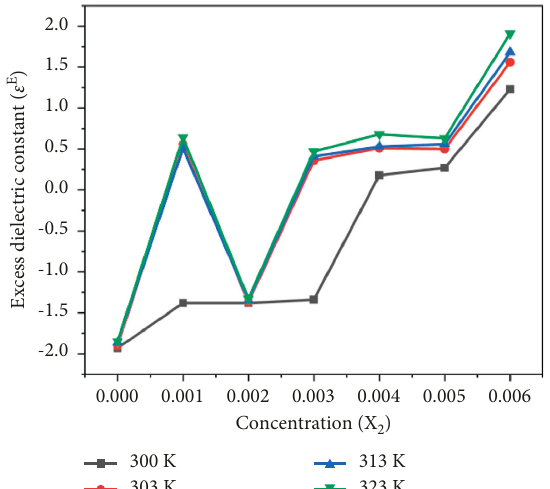
Figure 3: The variation of the excess dipole moment values of BaO: Therm500